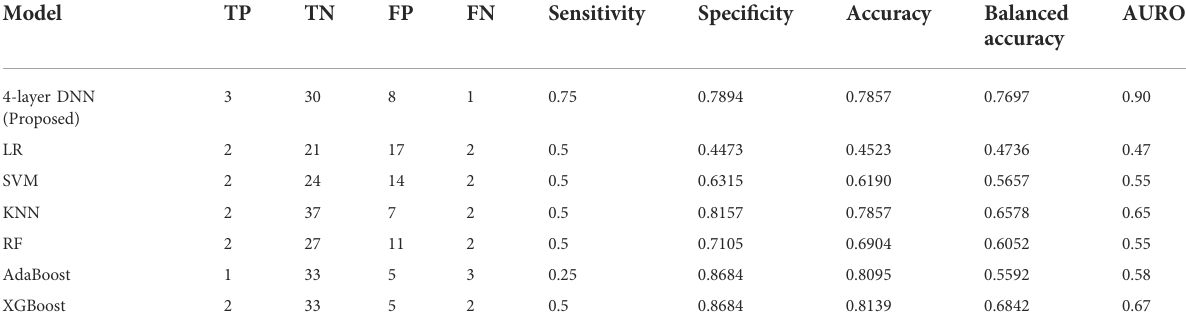
TABLE 6 Testing data